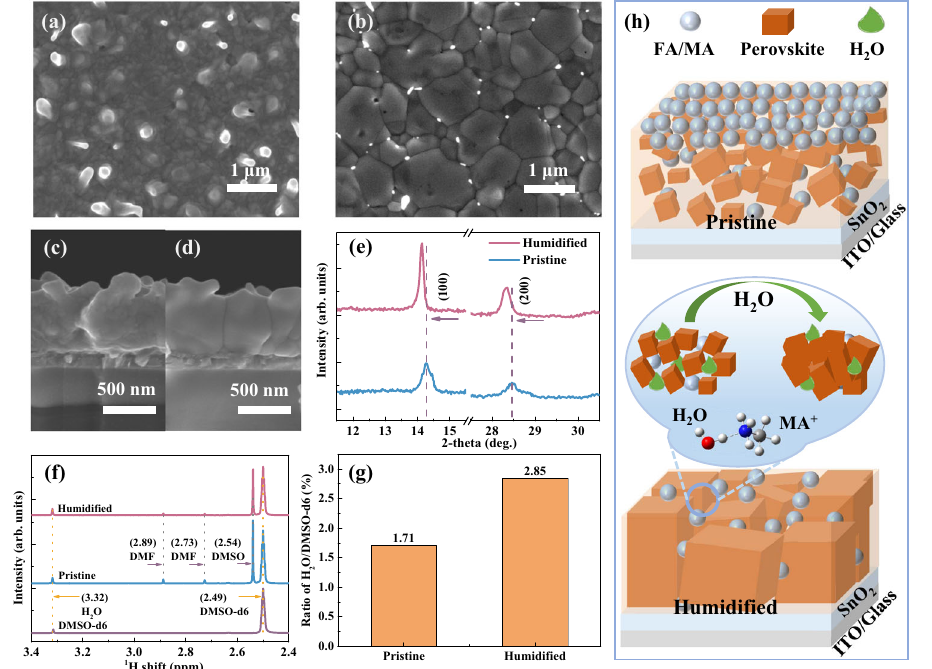
Fig. 3 | The effect of moisture treatment on the morphology and structure of the wet intermediate perovskite fi lm before annealing. The morphology evo- lution and crystallization change of the same intermediate perovskite fi lm from pristine state to humidi fi ed state: a , b Top-view SEM images; c , d Cross-sectional SEM images; e XRD patterns. f 1 H NMR spectra of DMSO-d6, the pristine